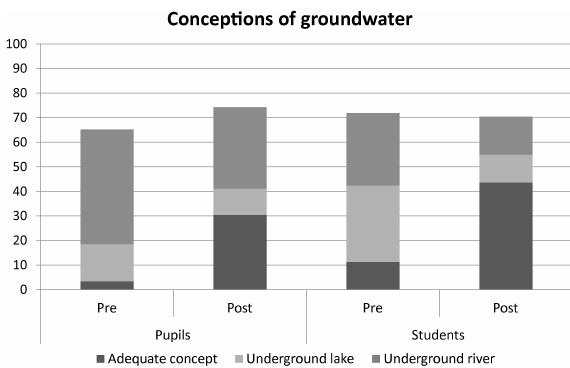
Figure 8. Comparison of the correct and most frequently mentioned incorrect groundwater conceptions of pupils and students from the experimental group in the pre- and